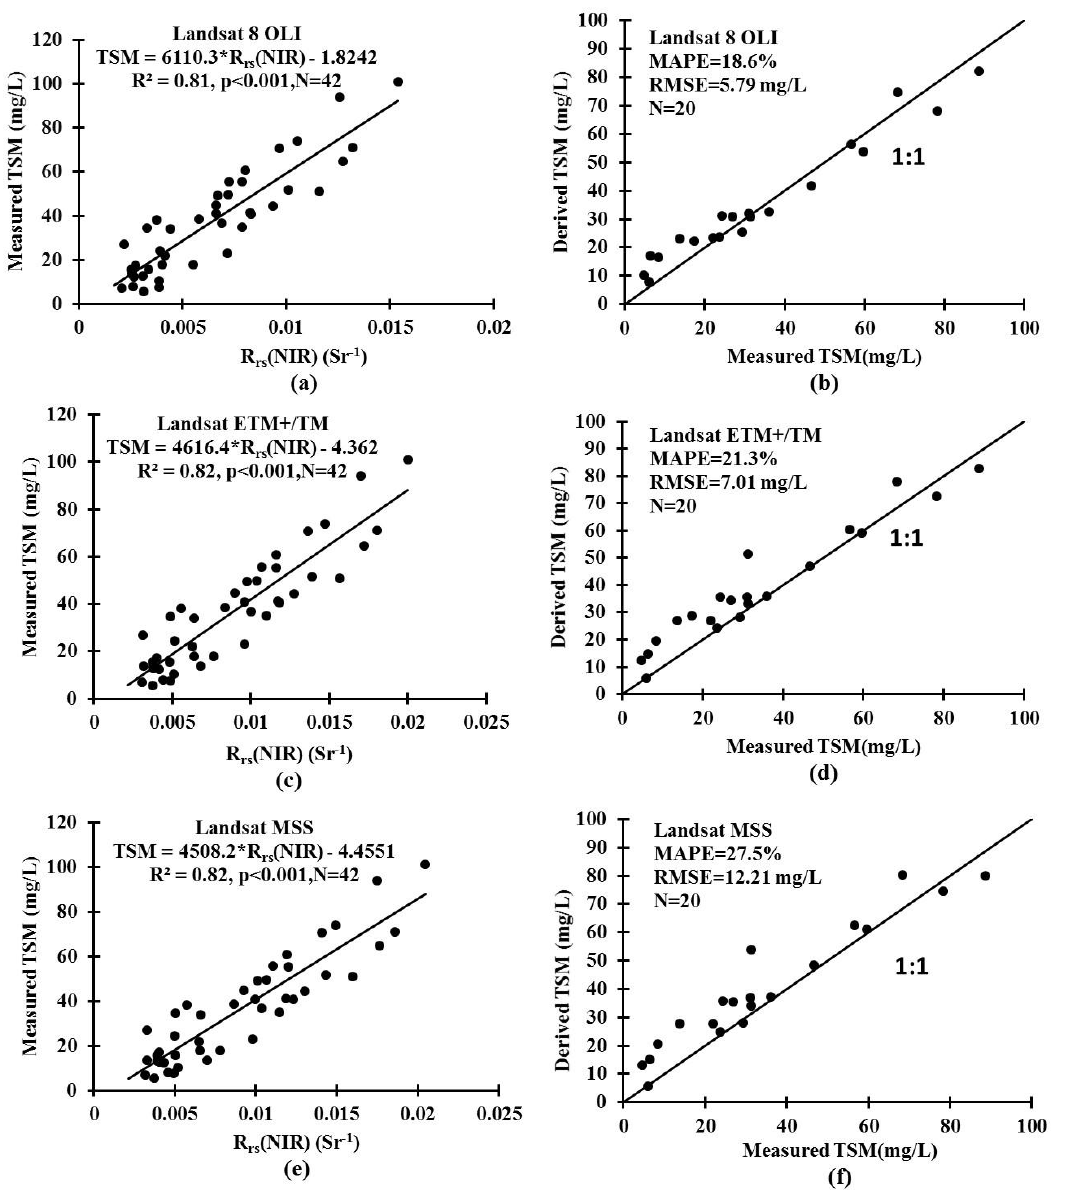
Figure 2. Scatter-plots of TSM-model calibration ( left ) between in situ TSM-measurement data and simulated Landsat-based derived R rs , and TSM-model validation ( right ) between measured and Rrs-based derived TSM using Equations (5–7). ( a ) & ( b )based on Landsat 8 OLI sensor, ( c ) & ( d )based on Landsat ETM + /TM sensor, ( e ) & ( f )based on Landsat MSS sensor. TSM is